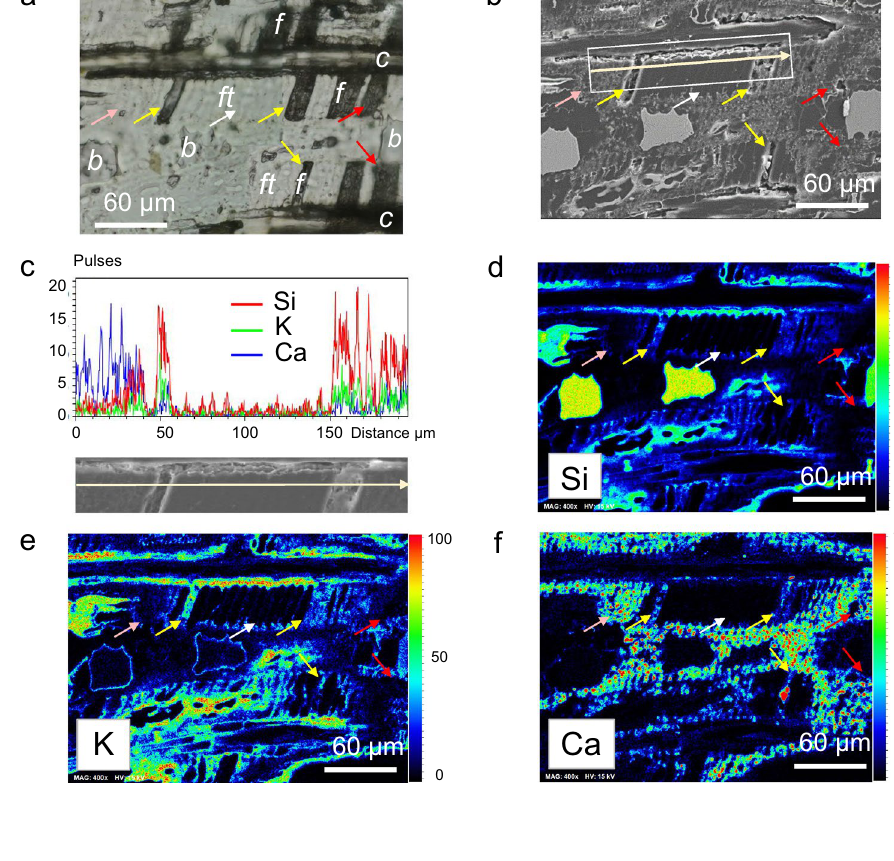
Fig. 7 Foliar transverse section of a vascular bundle with two fusoid cells (Primavera-10). a Light microscope picture; b SEM image with three defined AOIs (AOI 1 showing the back- ground); c EDS spectra of the demarcated AOIs; d EDS